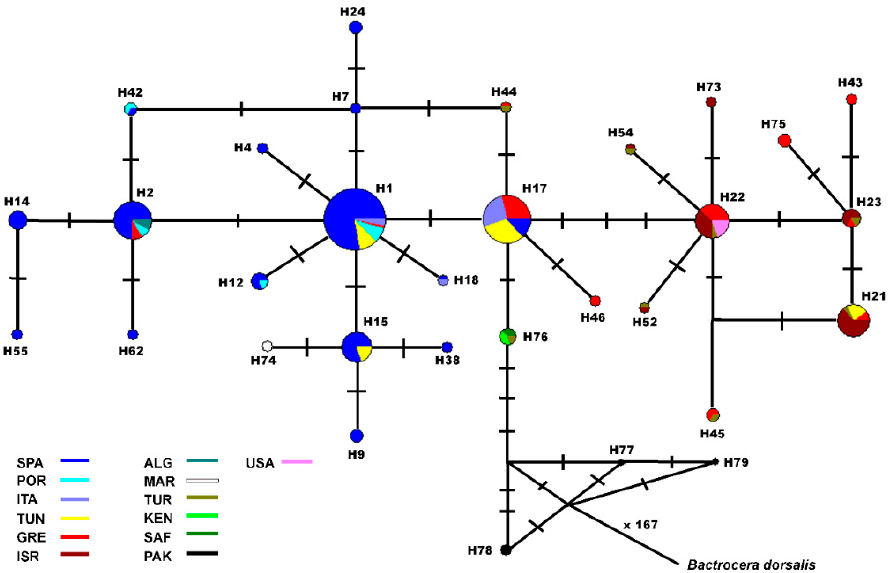
Figure 4. Haplotype network of the concatenated COI haplotypes generated by the “median-joining” method. The area of the circles is proportional to the haplotype frequency. Bars correspond to mutational steps between haplotypes. Colours represent the sampled countries. ALG, Algeria; MOR, Morocco; KEN, Kenya; SAF, South Africa; PAK, Pakistan.